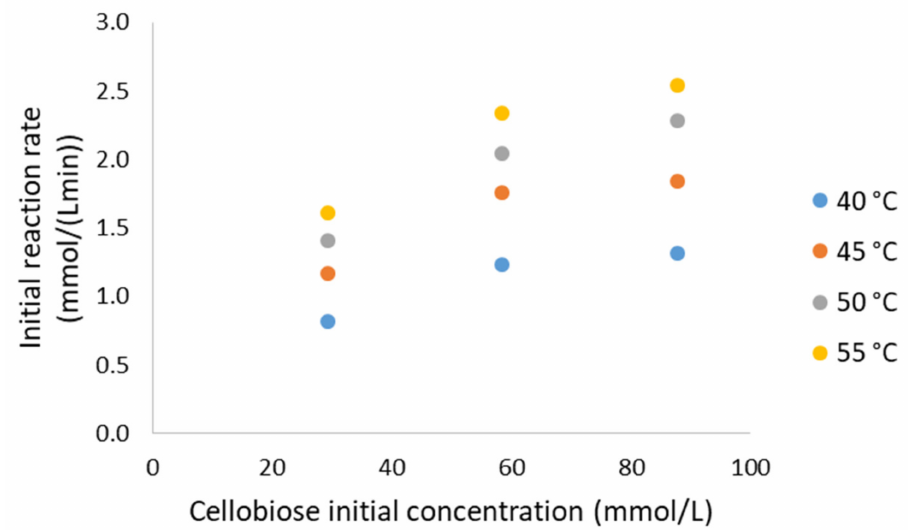
Figure 4. Initial reaction rate versus initial concentration of cellobiose at several